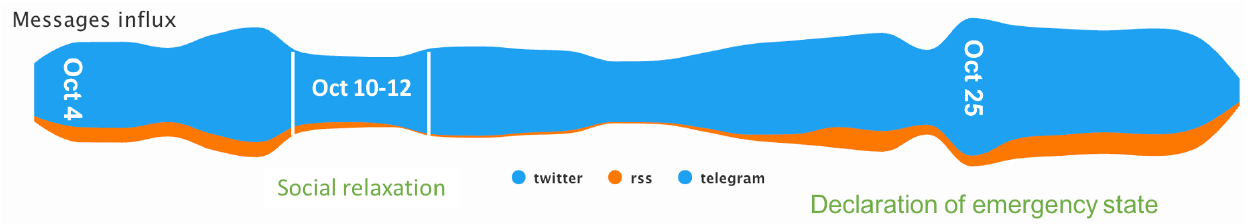
Figure 7. The number of messages on social networks (i.e., Twitter, RSS, and Telegram) about Coronavirus in Spain during the vacation period in October